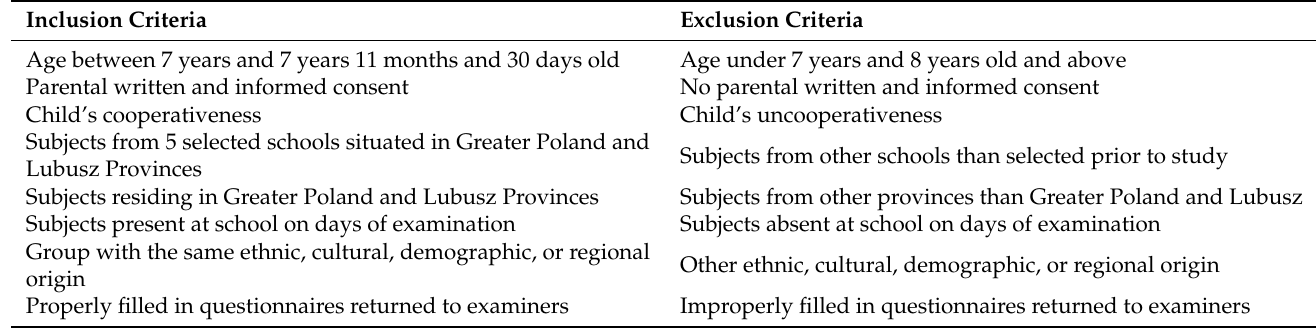
Table 1. Inclusion and exclusion criteria for 7-year-old individuals and their parents/caregivers in the study. Inclusion